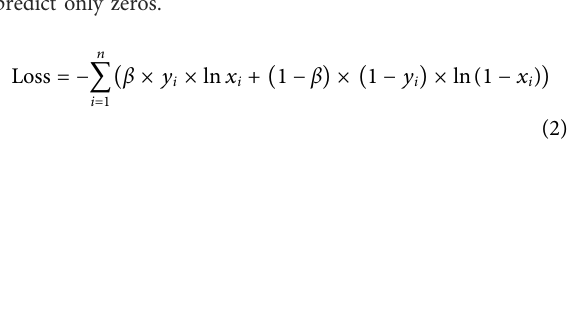
pixels of caves and non-caves in the label data set, respectively. Y denotes the total number of pixels in the label data set. Using the class-balancing weight β on a per-pixel term basis, the binary cross-entropy loss with additional trade-off parameters for biased sampling helps the network converge in the correct direction.